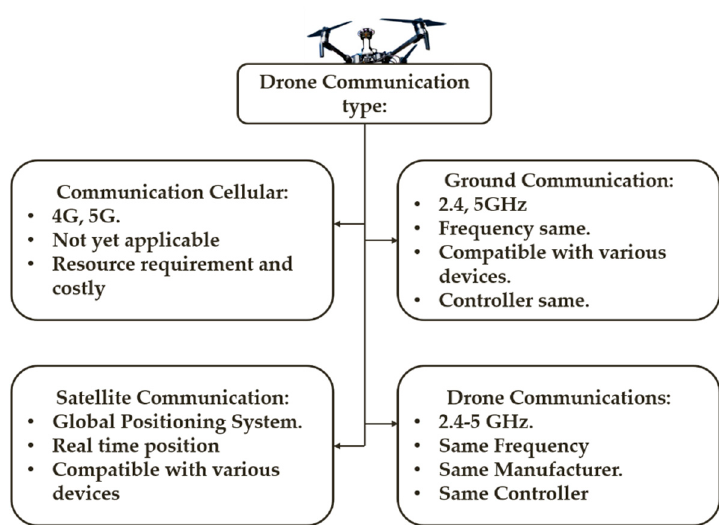
Figure 1. UAV/drone communication.